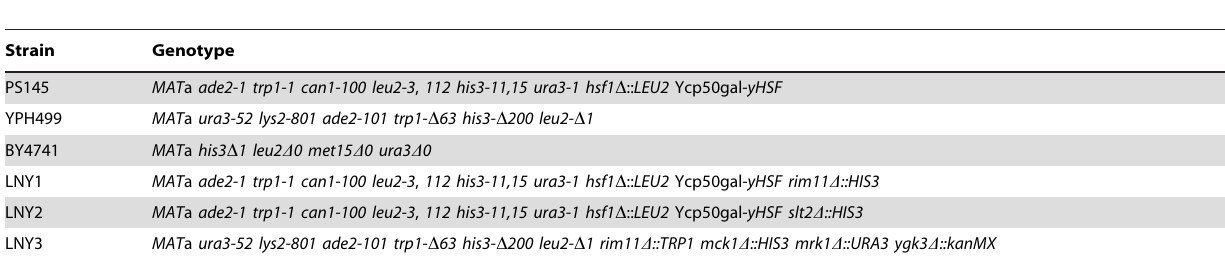
Table 1. Yeast strains used in this